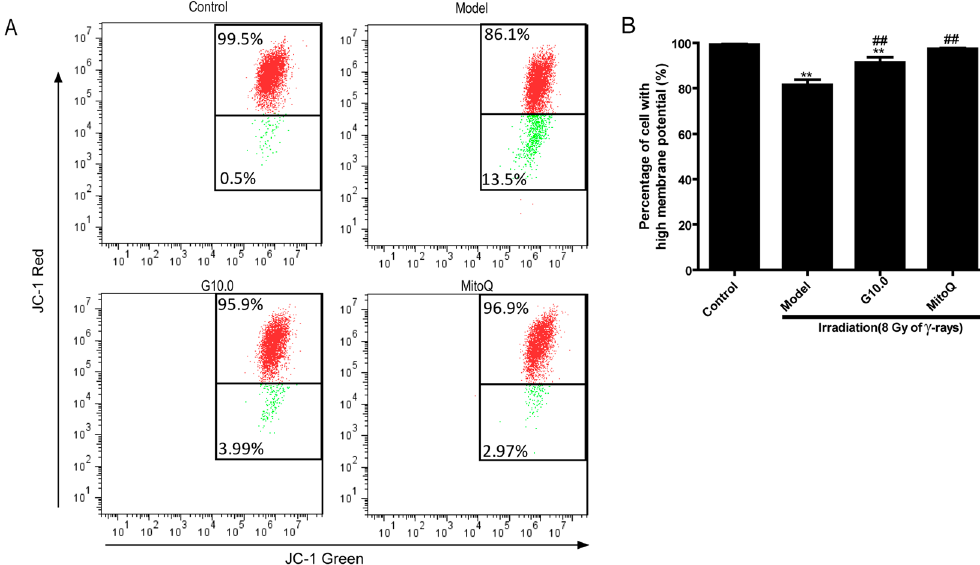
Figure 3. Effect of GSPs on mitochondrial membrane potential in irradiated HFL1 cells. ( A ) Flow cytometry analysis of JC-1 staining was used to assess mitochondrial membrane potential (MMP). HFL1 cells were pre- treated with GSP (10 μ g/ml) or MitoQ (200 nmol/L) for 24 h before irradiation, and MMP was determined at 72 h after irradiation. One representative flow cytometry plot of the mitochondrial membrane potential is shown out of three replicates. The cells with enhanced red fluorescence had a higher membrane potential. The numbers in the corners represent the percentage of cells in the corresponding quadrants. ( B ) The percentage of cells with high MMP (%) is shown. Data are expressed as the mean ± SEM of three independent experiments. * P < 0.05 and ** P < 0.01 versus control group. ## P < 0.01 versus model